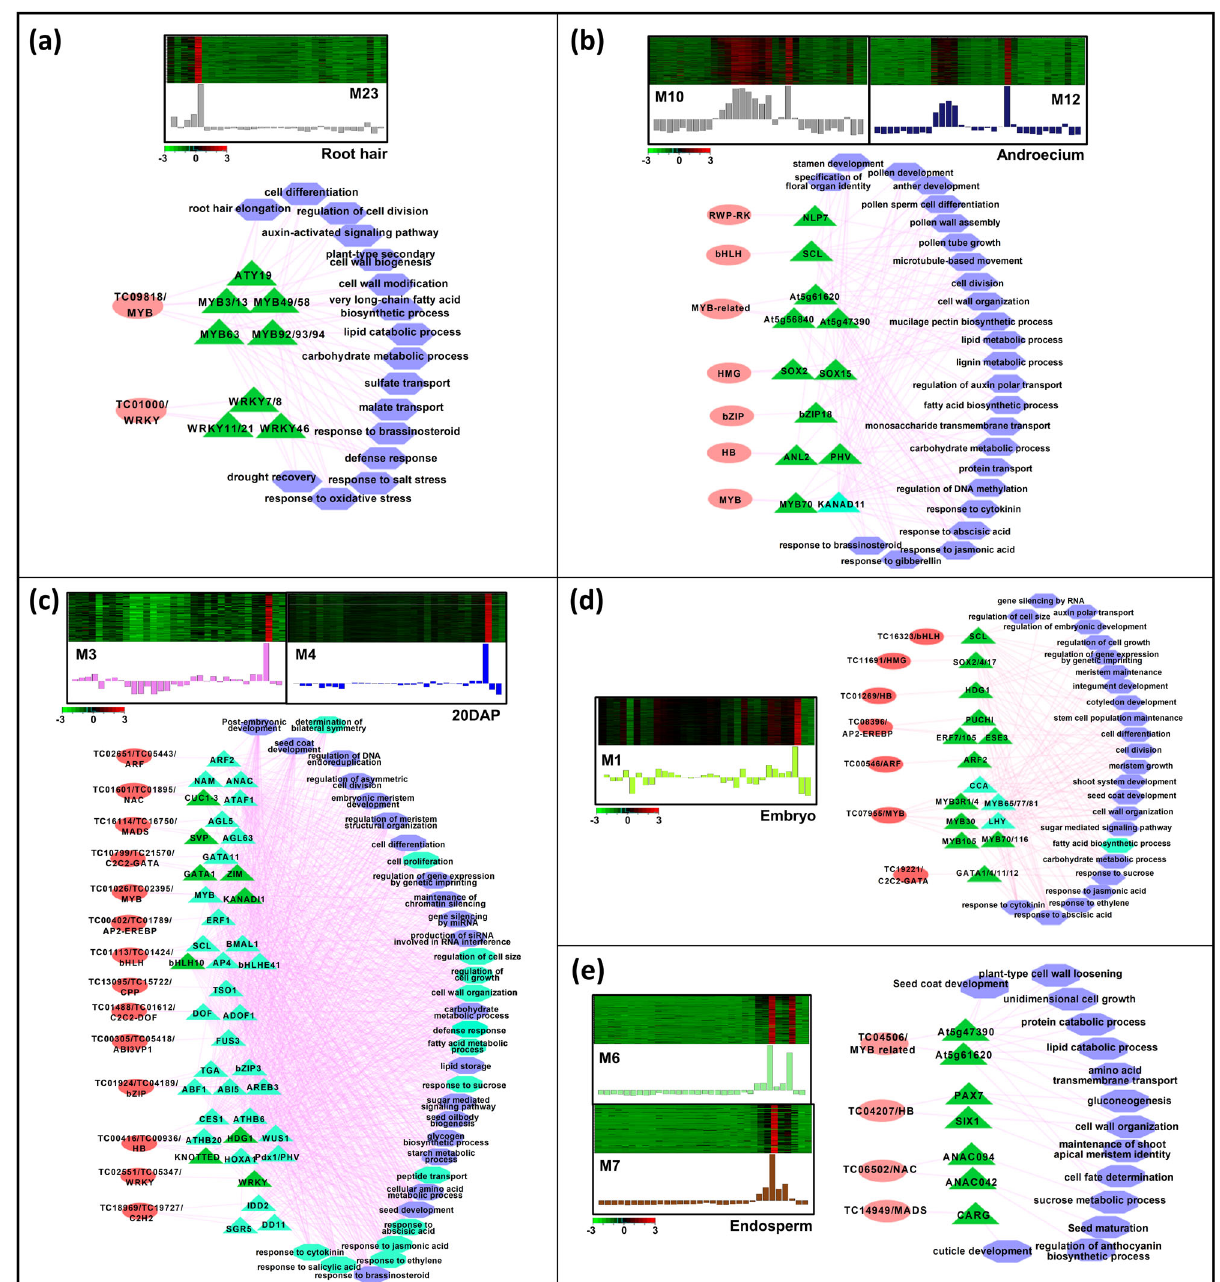
Fig. 6 Expression pro fi le and transcriptional regulatory network associated with the modules correlated to a speci fi c tissue or stage of development. Heatmaps show the expression pro fi le of all the coexpressed genes in the module(s) correlated with the given speci fi c tissue, including root hair ( a ), androecium ( b ), 20DAP ( c ), embryo ( d ), and endosperm ( e ). Color scales represent Z -score. Bar graphs (below the heat maps) show the consensus expression pattern of the coexpressed transcripts in each module. The predicted transcriptional regulatory network (signi fi cantly enriched TF-binding sites along with the associated TFs and GO terms) associated with the transcripts sets in the modules are shown below the heatmaps. The signi fi cantly enriched cis-regulatory motifs only in protein-coding genes (PCGs), and both PCGs and lncRNAs are shown by green and sea green triangles, respectively. The associated GO terms only in PCGs, and both PCGs and lncRNAs are shown by blue and sea green hexagons, respectively. The TFs are represented by pink ovals. Edges represent known interactions between the cis -regulatory motifs and transcription